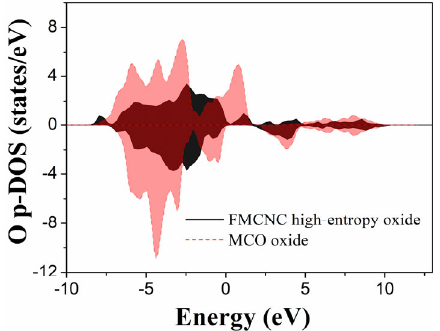
Fig. 7 O p-DOS for FMCNC high-entropy oxide and MCO oxide.